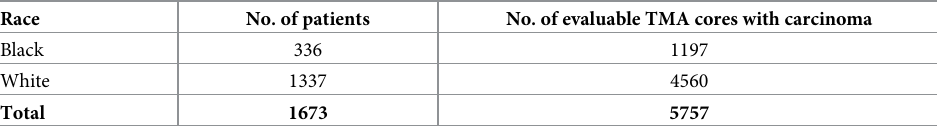
Table 1. Total number of patients and TMA spots with carcinoma.